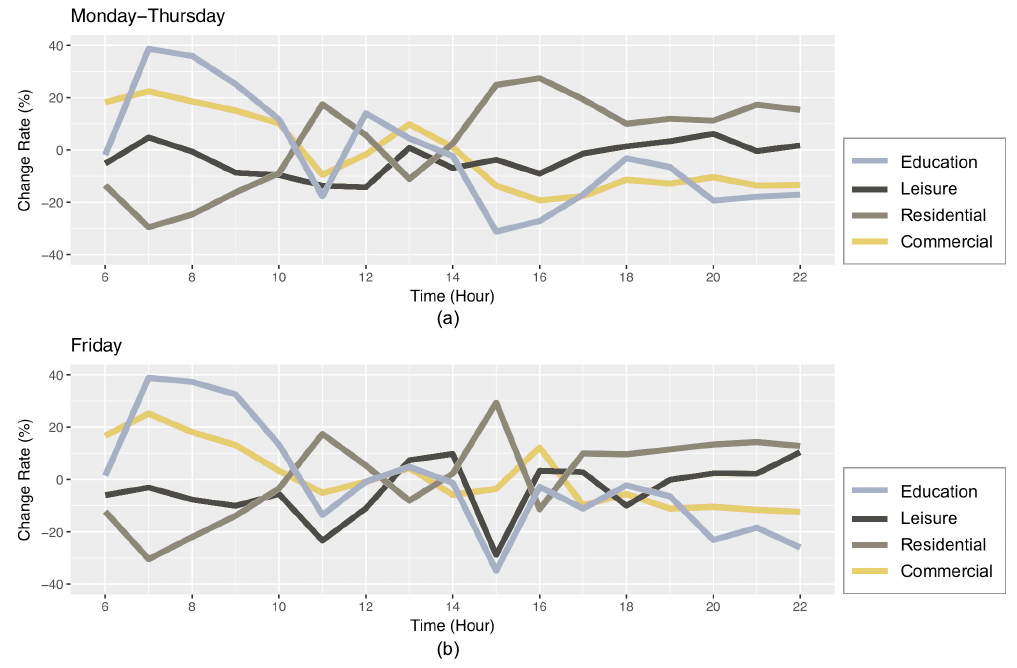
Figure 10. The change rates for different categories of land use for ( a ) Mondays to Thursdays, and ( b ) Fridays, for Student travellers.